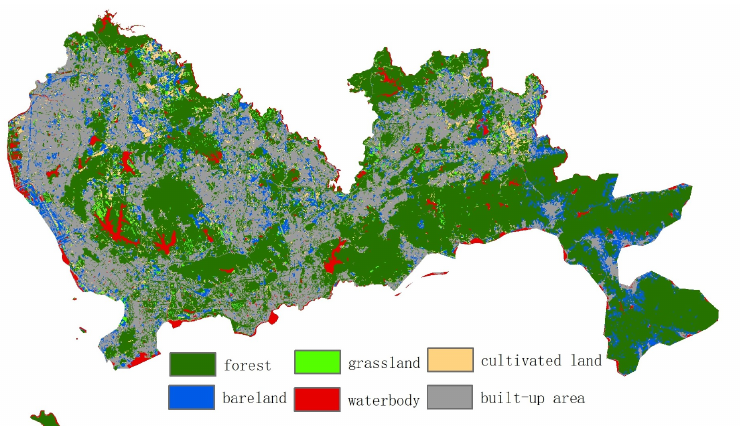
Figure 5. Forecast results of land use/land cover in Shenzhen in 2015 with the diffusion equation. In the comparison experiment, we used the CA–Markov model provided in the IDRISI software as a comparison. The state transition matrix of Shenzhen from 2011 to 2013 and the land-use/land-cover of Shenzhen in 2013 were input in the software, and the spatial neighborhood size was set as the 8 neighborhood. Finally, we created the land-use/land- cover situation in Shenzhen in 2015, Figure 6, and the Kappa coefficient of the experimental result is 0.6741.